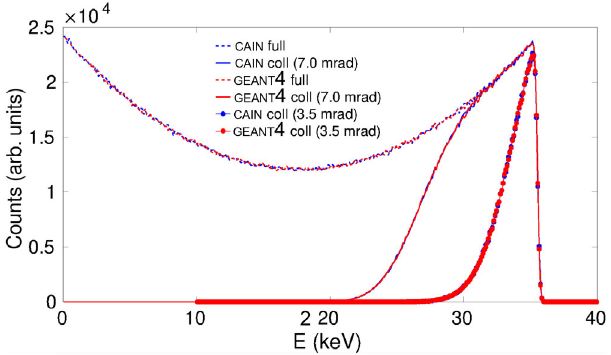
FIG. 2. Full and collimated spectrum of the BriXS photon beam simulated with CAIN and GEANT 4